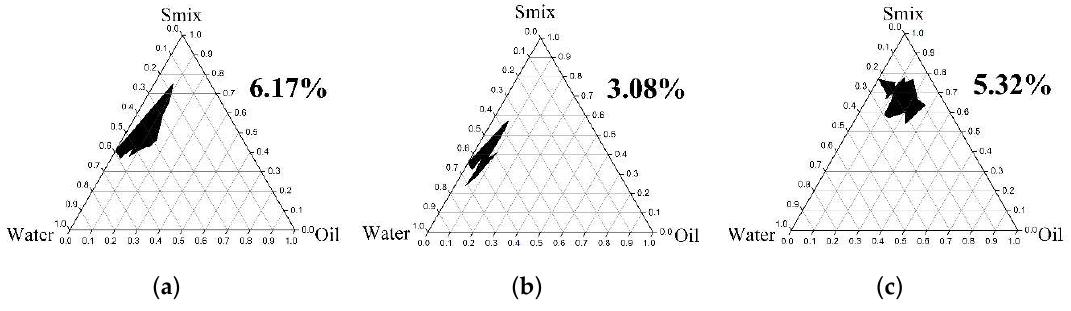
Figure 4 . Pseudoternary phase diagram of CA / Tween 85 and co - surfactant ( 1 : 1 )/ water, when the co - surfactant was ( a ) ethanol; ( b ) isopropanol; ( c ) propylene glycol . The dark area represents the microemulsion region .